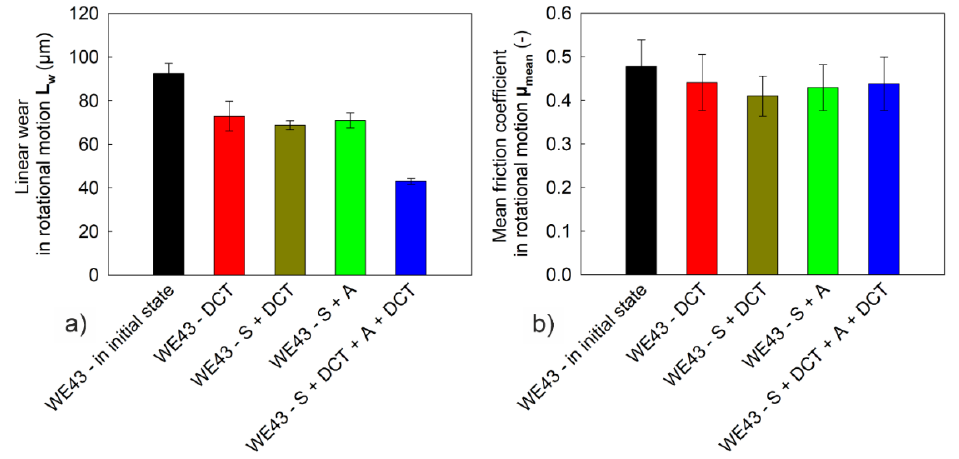
Figure 9. Volumetric wear V w of WE43 alloy in the initial state and after different heat treatment variants. The error bars represent a standard deviation ( σ Vw = 0.43 × 10 4 –1.57 × 10 4 mm 3 /Nm).